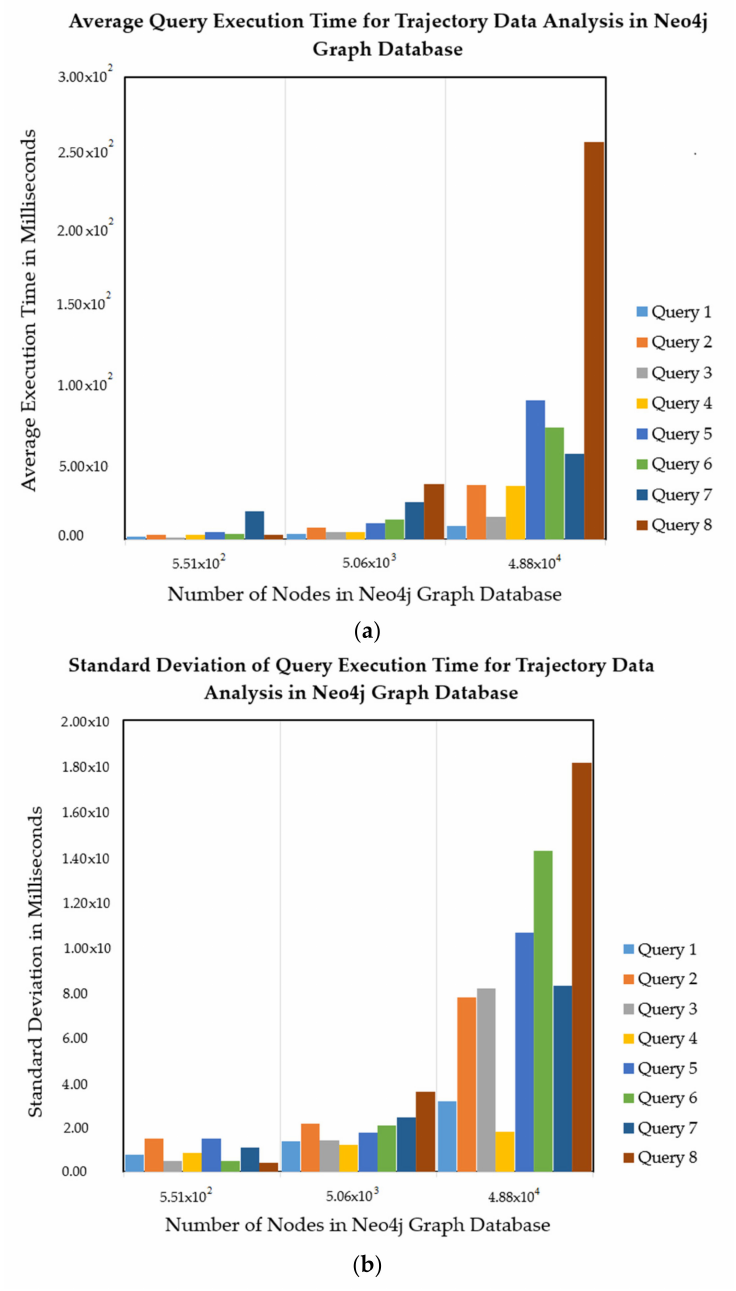
Figure 14. Representation of executing trajectory data analysis for 100 times in the Neo4j graph database with 551, 5058, and 48,826 nodes: ( a ) Showing average query execution time in milliseconds for different trajectory data analysis, ( b ) Representing standard deviation of query execution time in milliseconds for different trajectory